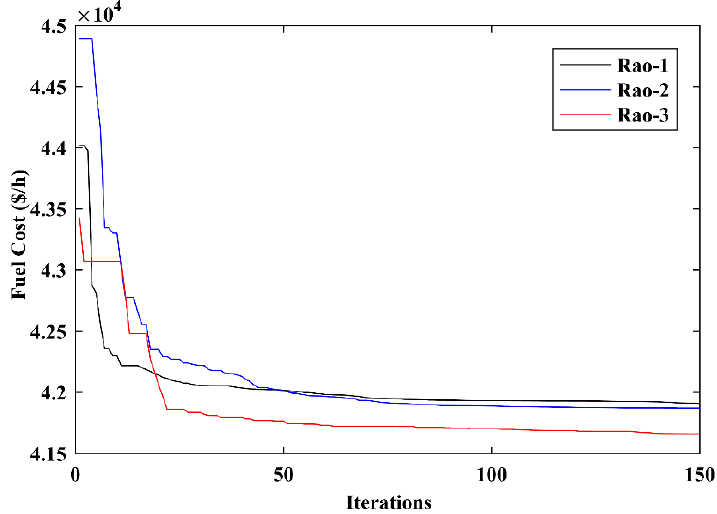
Figure 6. Convergence characteristics for the IEEE 57-bus system, Case 7. Table 11. Case 7 (FCM) results in the IEEE 57-bus system.